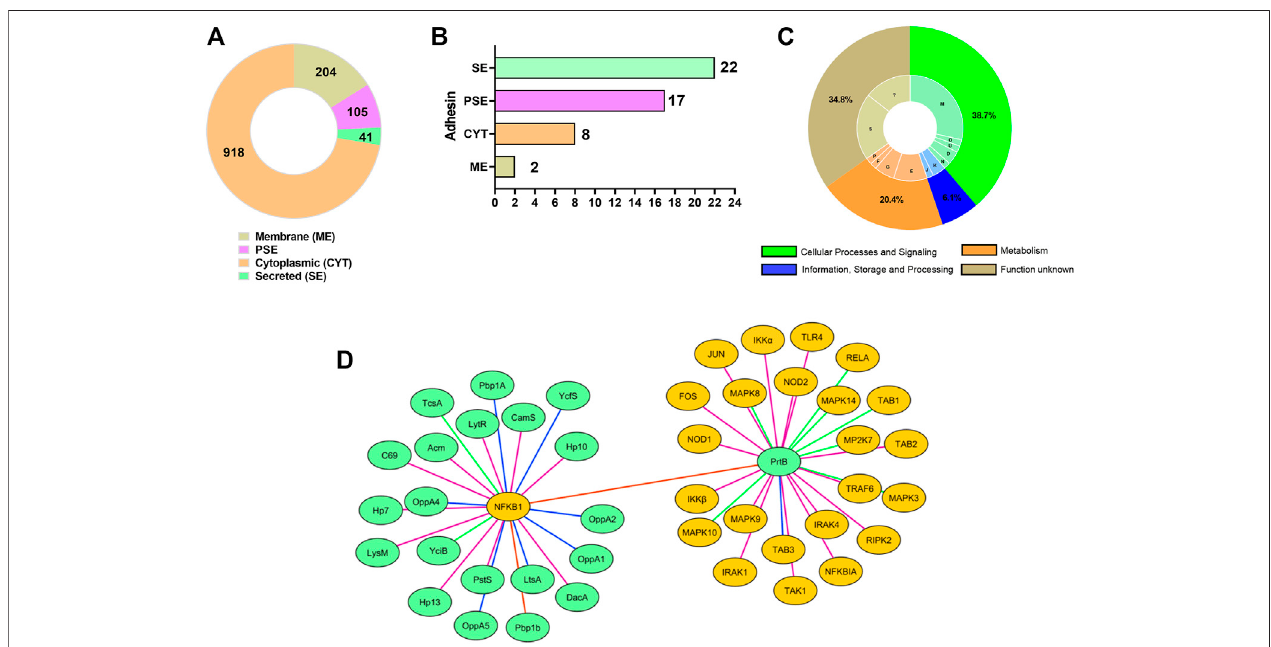
FIGURE 4 | Core proteins of L. delbrueckii strains interact with human immune proteins involved in in fl ammatory pathways. (A) Subcellular localization of core proteins. (B) The number of core proteins with adhesin pro fi le. (C) COG categories are assigned to core proteins with adhesin pro fi les. (D) Subnetwork mapping of L. delbrueckii core proteins (green circles nodes) interacting with human immune proteins (yellow, dark circle nodes). Different line colors indicates the interaction degree between the proteins, based on interaction score: 0.97 (green line), 0.98 (purple line), 0.99 (blue light line), 1.0 (red